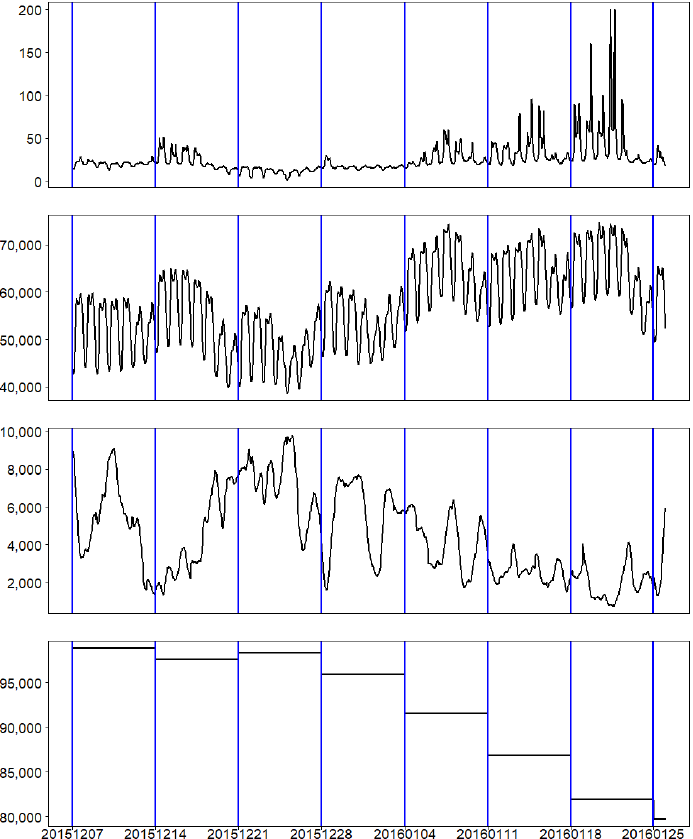
Figure 7. The day-ahead electricity prices, electricity consumption forecasts, wind power generation forecasts and the current water level in hydroelectric reservoirs (7 December 2015–25 January